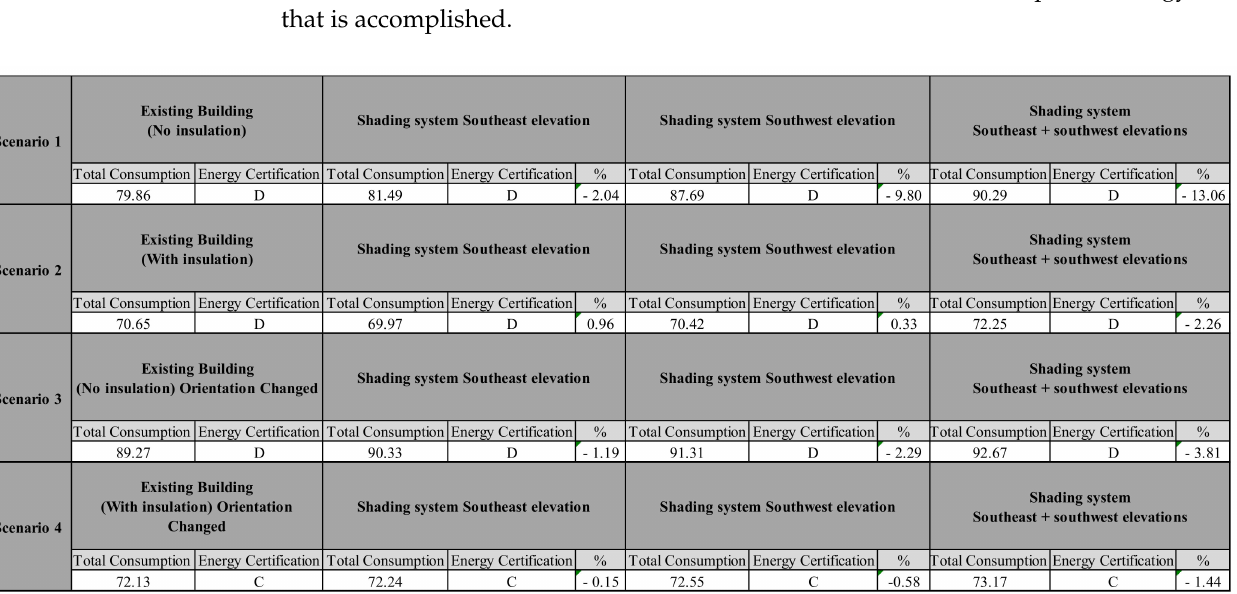
Figure 13. Calculation of the final energy consumption with CYPETHERM HE Plus (kWh/m 2 year) and the improvement (%) of the shading